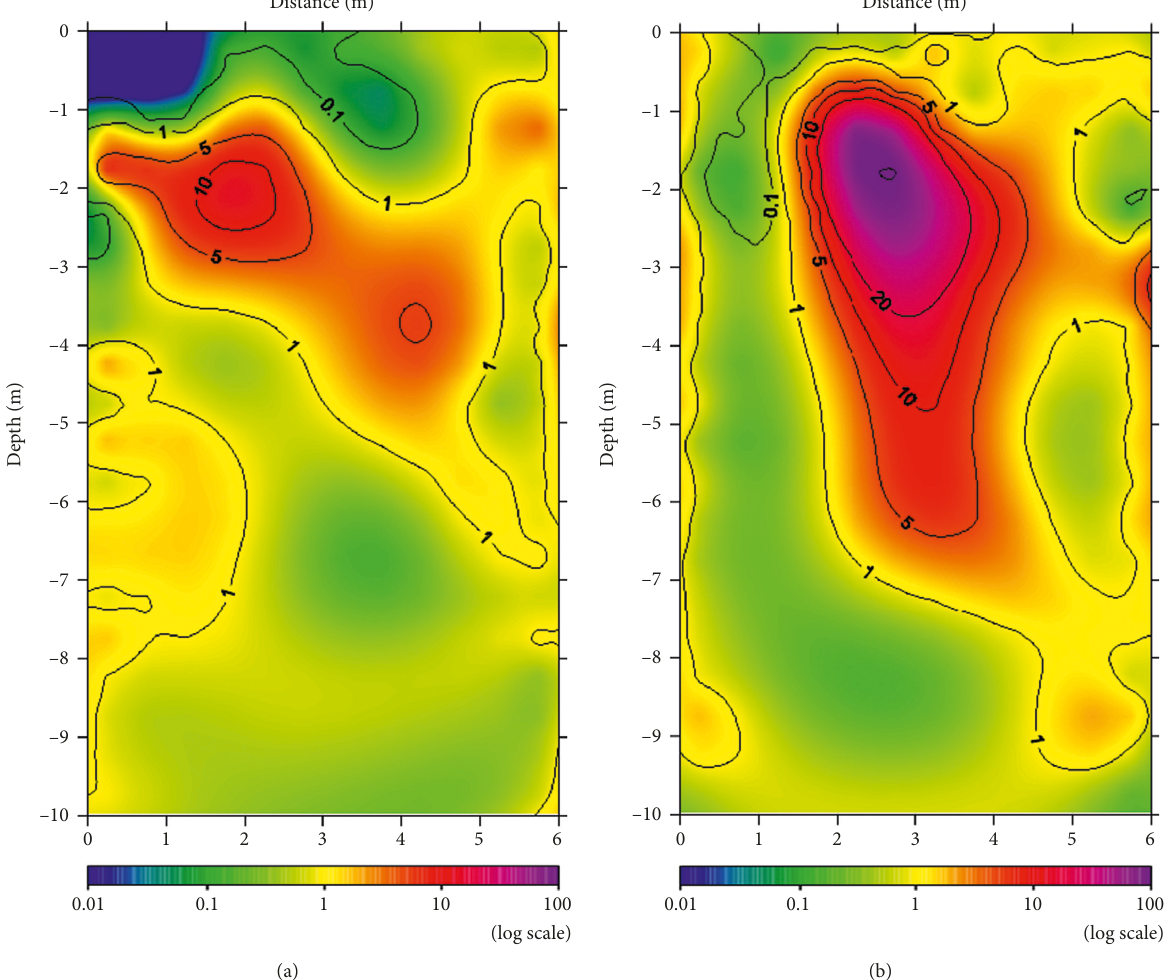
Figure 12: Electrical resistivity ratio contours of the 3rd test over 1st test (a) and (b) 3rd test over 2nd